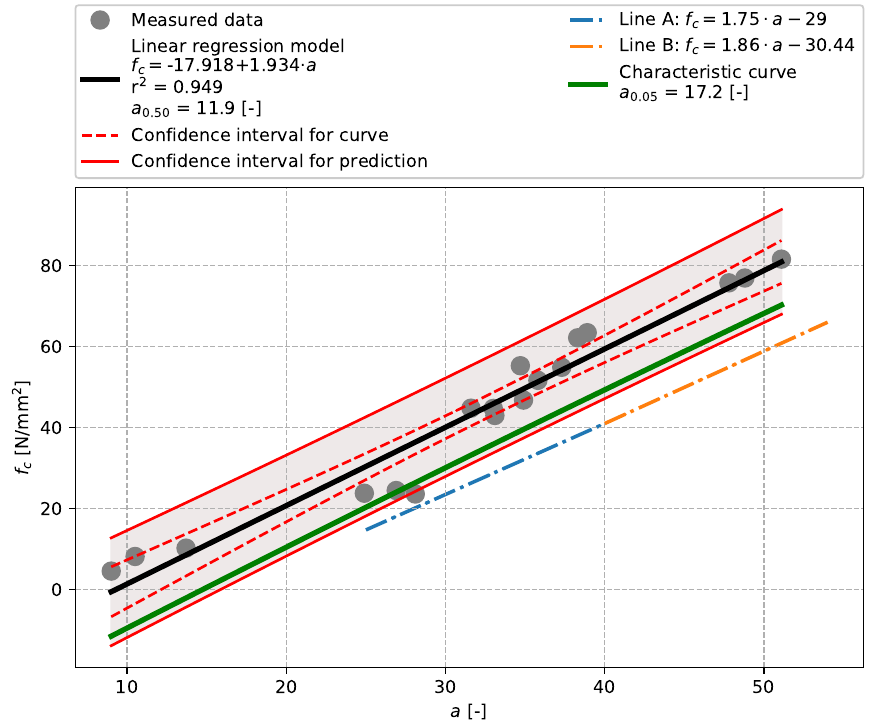
Figure 7. Precast concrete described in Section 3.2—model of the dependence of a [-] vs. compressive strength f c [N/mm 2 ]—Original Schmidt N.